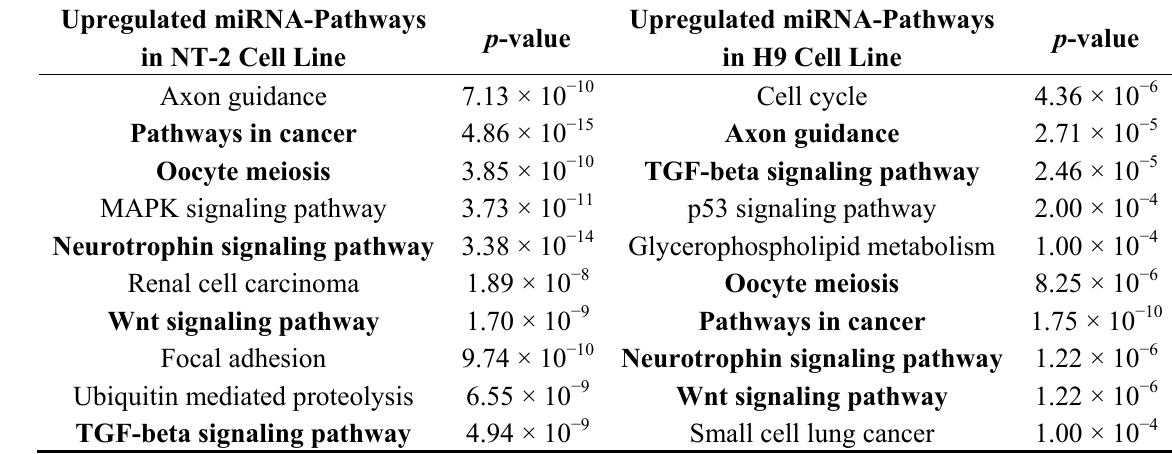
Table 3. Enriched miRNA-pathways in NT-2 and H9 cell lines. Analysis of KEGG pathway enrichment for gene targets of regulated miRNAs identified in the cultures of the two cell types (H9 and NT-2) exposed to MeHgCl (compared to untreated cells). The overlapping pathways between H9 and NT-2 cell lines are marked in